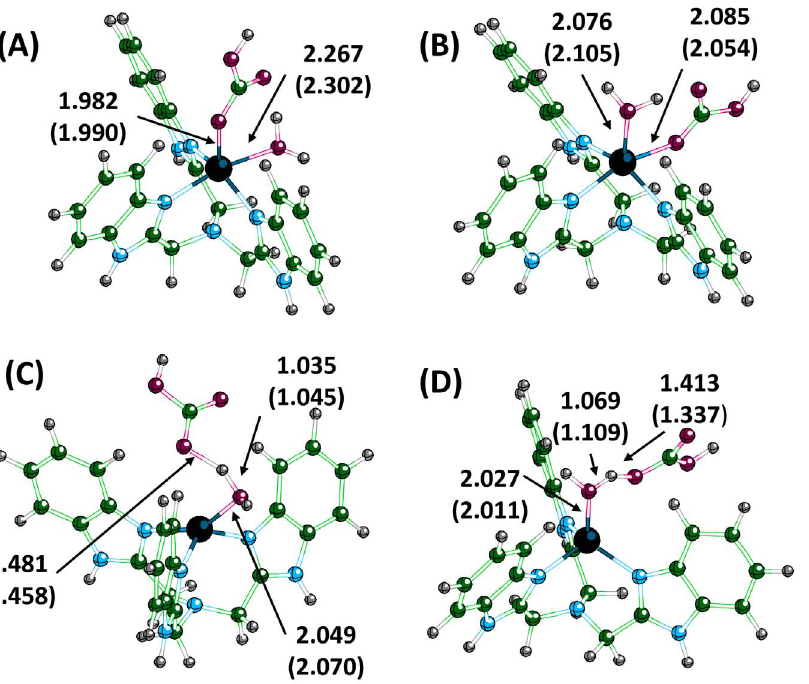
Figure 7. Optimized geometries for the bicarbonate and water bound to Ben-Zn with the bicarbonate in the equatorial position (A) and axial position (B). The equatorial structure is the most stable. Panel (C) and (D) show the corresponding transition states for (A) and (B), respectively. Values are in angstroms and values in parenthesis are for the corresponding cobalt structures. doi:10.1371/journal.pone.0066187.g007 their respective transition states was almost identical in value.